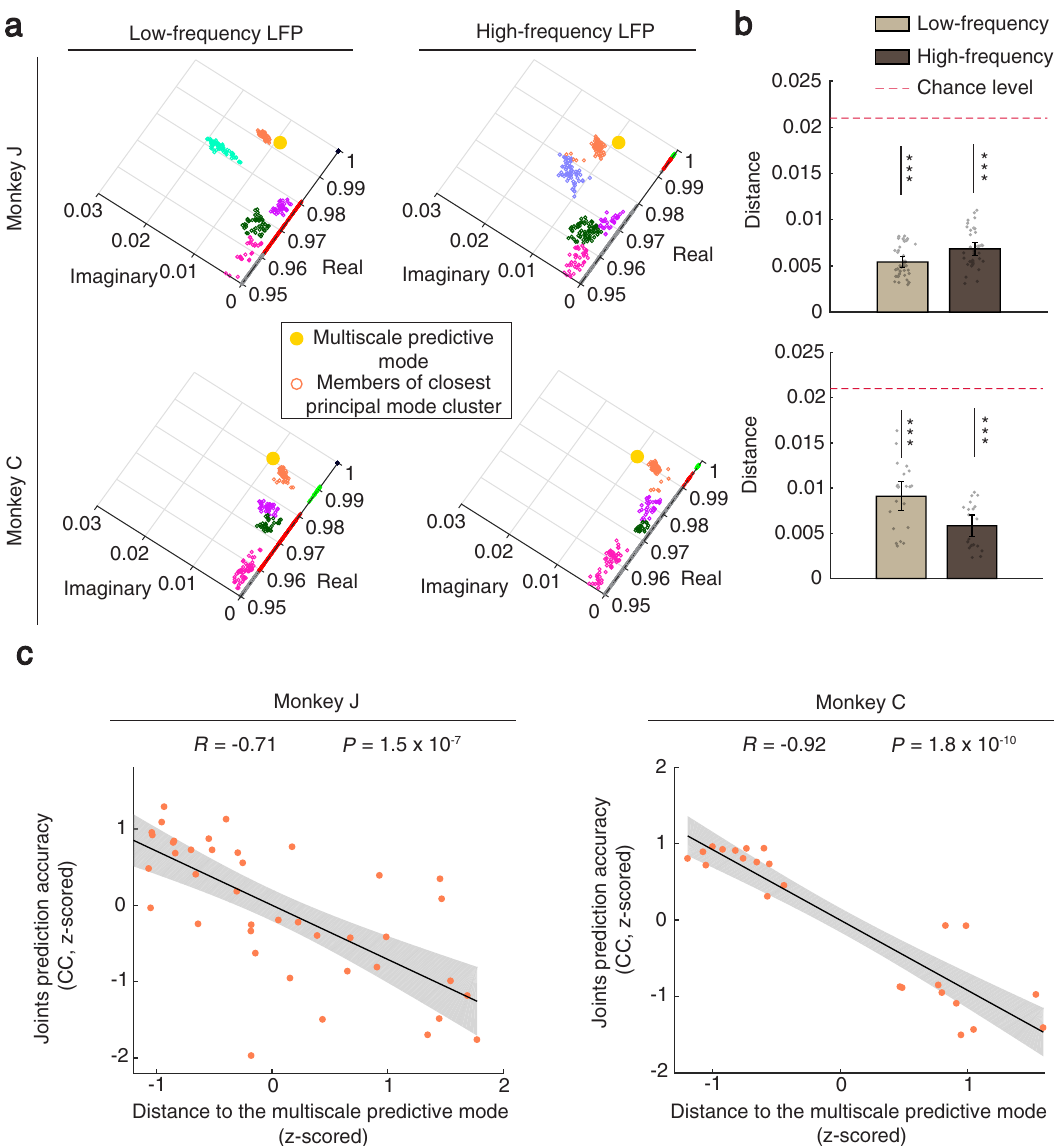
Fig. 7 The multiscale predictive mode was present in both low-frequency and high-frequency bands of LFP activity. a For a sample experimental session (top: Monkey J, bottom: Monkey C), the top view of the eigenvalue-dimension diagram is shown for low-frequency (theta + alpha + beta; left) and high- frequency (gamma; right) bands of LFP activity. The yellow circle is the average location of the predictive mode clusters in the spiking network activity in Fig. 5b, which we used as the ground-truth location of the multiscale predictive mode in this analysis. The members of the closest estimated principal mode cluster to the yellow dot are shown in orange. b In both monkeys and for both low-frequency and high-frequency bands of LFP activity, the mean distance of the closest estimated principal mode cluster to the multiscale predictive mode was signi fi cantly smaller than chance-level as shown by the asterisks with similar convention as in Fig. 3 ( P < 6.4 × 10 − 5 , N s = 35 and 20 cross-validation folds across sessions for Monkeys J and C, FDR-corrected, one-sided Wilcoxon signed-rank test). The distance in each session is calculated between the centroid of the orange cluster and the yellow dot in ( a ). Bars represent mean across sessions and error bars are 95% con fi dence bound of the mean. c The distance of the estimated principal mode to the multiscale predictive mode is correlated with the behavior prediction accuracy for different frequency band combinations of LFP activity (theta + alpha, beta, gamma in addition to their pairwise combinations: theta + alpha + beta, theta + alpha + gamma and beta + gamma; P < 1.5 × 10 − 7 , N s = 42 and 24 frequency band combinations across sessions for Monkeys J and C, one-sided Wilcoxon signed-rank test, FDR-corrected). For each monkey, each dot represents one frequency band combination for one session. The distance and the prediction accuracy of the estimated principal mode in each session are z scored and then results are pooled across sessions. Similar to Fig. 6, black line is the linear least-square fi t representing the mean prediction accuracy and the shaded area is the 95% con fi dence bound of the mean. Source data are provided as a Source Data fi with a decrease of 0.05 (from 0.4 to 0.35) when increasing the decay 10 times (Fig. 8c). Therefore, prediction accuracy decreased more when the perturbation led to smaller decays (fast-decaying) compared to larger decays (slow-decaying), again indicating that integrating information over larger time intervals of at least 1 s is